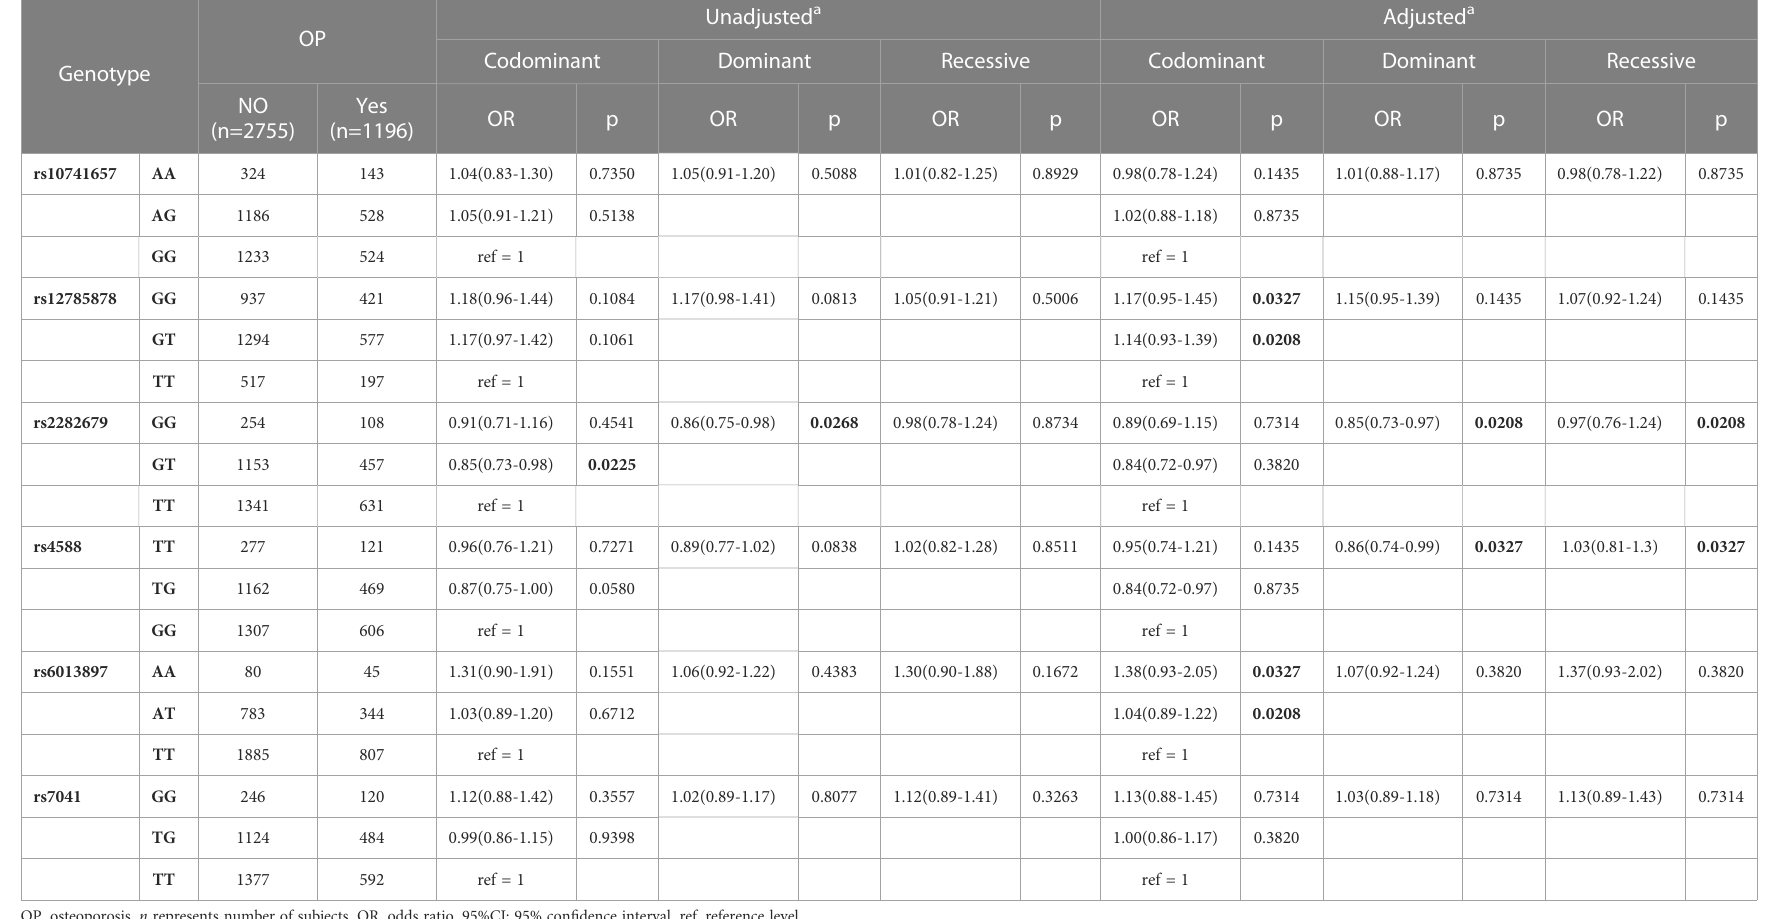
TABLE 3 Association between single nucleotide polymorphisms and OP after multiple imputation.